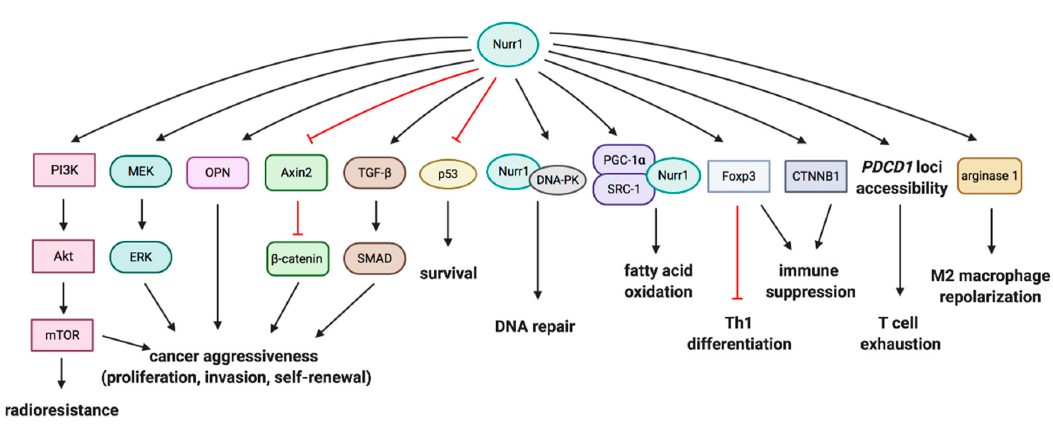
Figure3. DownstreamsignalingofNurr1andtheassociatedfunctionsincarcinogenesisandsuppression Figure 3. Downstream signaling of Nurr1 and the associated functions in carcinogenesis and of antitumor suppression of antitumor immunity.